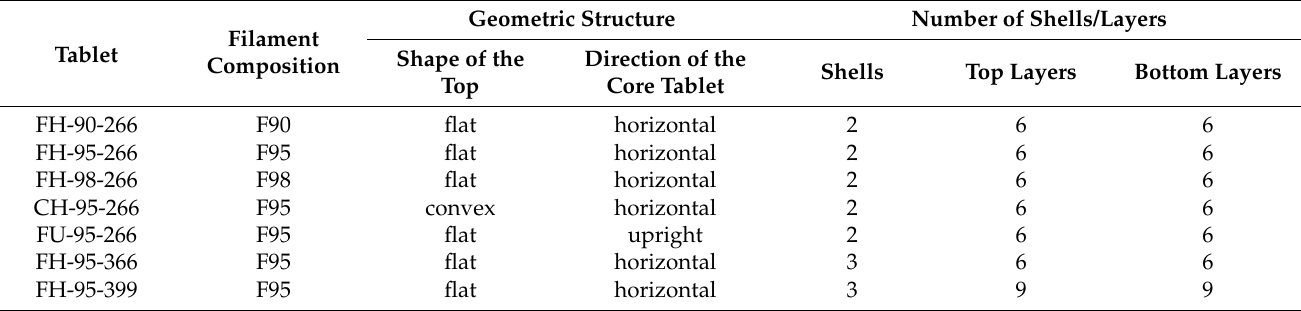
Figure 2. 3D-printed tablets with different thicknesses of outer shell: ( A ) FH-95-266, ( B ) FH-95-366, ( C ) FH-95-399. Table 1. Design of the outer shell of the core–shell 3D-printed pulsatile